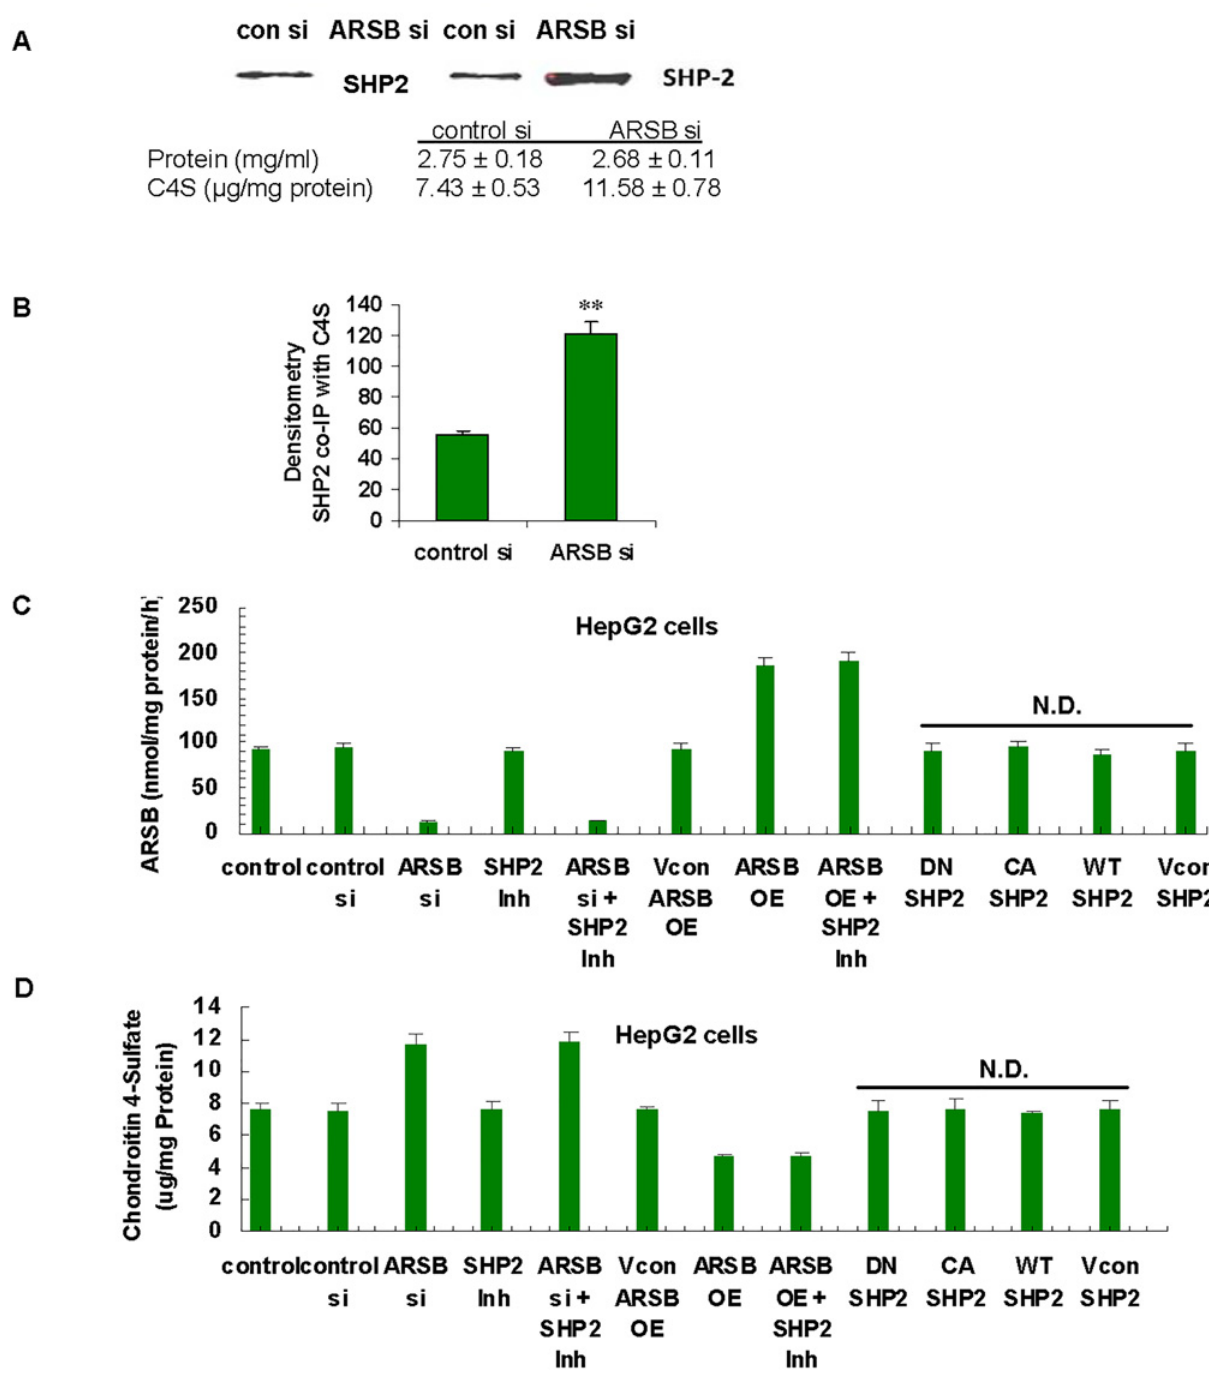
Fig 6. Increase in SHP2 that co-immunoprecipitates with C4S following ARSB knockdown. (A) Western blot of SHP2 co-immunoprecipitated with C4S shows increased band density following ARSB silencing compared to control silencing (n = 2). The C4S content increased following ARSB silencing, with similar protein. (B) Densitometry showed increased intensity of the immunoprecipitated bands following ARSB silencing (p = 0.007, unpaired t-test, two- tailed; n = 2). (C) HepG2 cells were treated with PHSP1, a chemical SHP2 inhibitor and with DN, CA, or WT SHP2 DNA vectors. These exposures had no effect on the ARSB activity. (p > 0.05, one-way ANOVA with Tukey-Kramer post-test; n = 3). (D) Treatment with PHSP1 or with DN. CA, or WT SHP2 DNA vectors did not modify the chondroitin 4-sulfate in the HepG2 cells. [ARSB = arylsulfatase B; CA = constitutively active; con si = control siRNA; DN = dominant negative; Inh = inhibitor; N.D. = no difference; OE = overexpression; si = siRNA; Vcon = vector control; WT = wild-type]